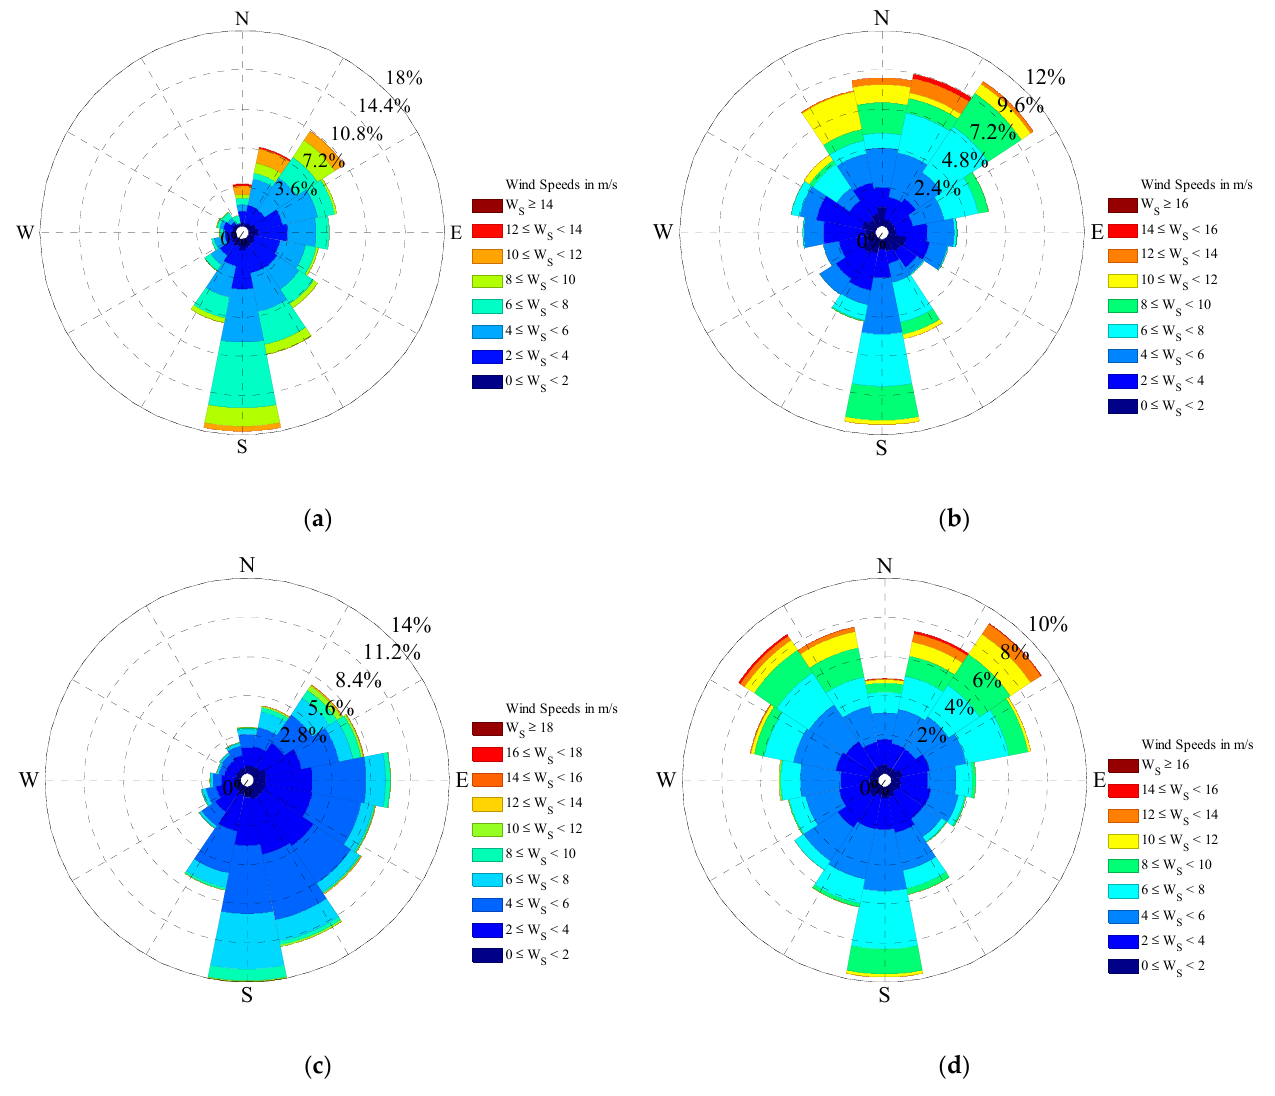
Figure 4. Wind rose in the wet season ( right ) and the dry season ( left ) in 2020 ( a , b ) and 2007–2017 ( c , d ) (wet season: 1 July–31 August; dry season: 1 January–28 February; data link: https://www.ecmwf.int/en/forecasts/datasets/reanalysis-datasets/era5, accessed on 29 March 2023). C. Tide Eight major tidal components ( M 2 , S 2 , N 2 , K 2 , K 1 , O 1 , P 1 , and Q 1 ) were selected for the